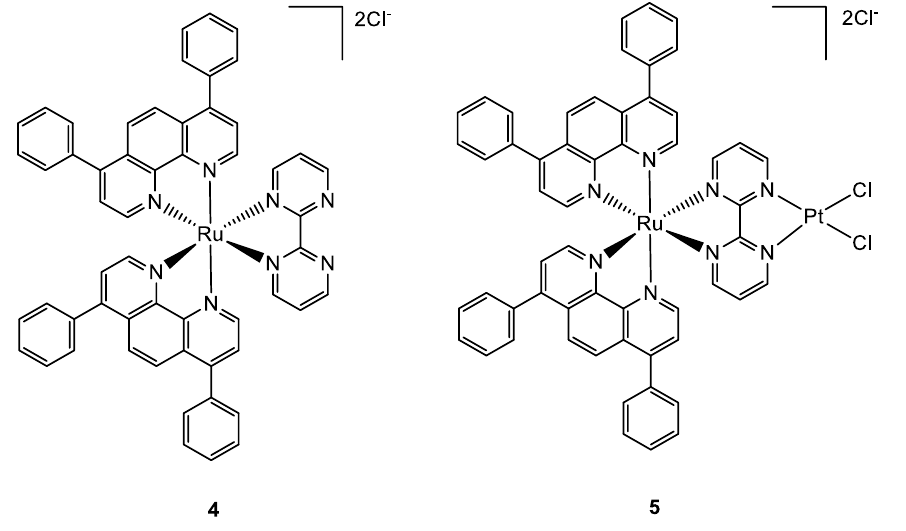
Figure 2. Molecular structure of compounds 4 and 5 .